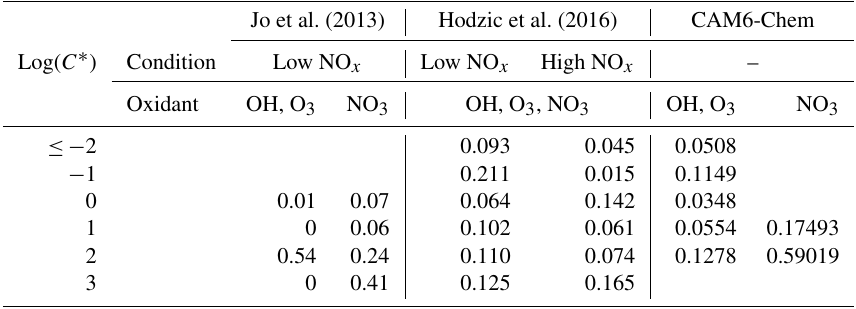
Table 4. Mass yield coefficient of monoterpene in Jo et al. (2013), Hodzic et al. (2016), and CAM6-Chem in VBS bins. C ∗ is the saturation concentration (µgm − 3